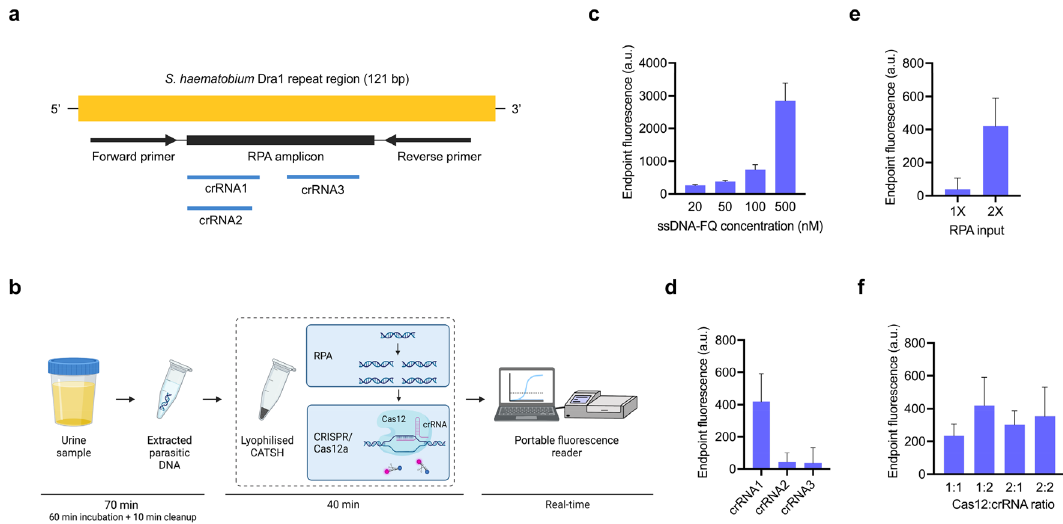
Figure 1. CATSH design and optimisation. ( a ) Visualisation of the targeted S. haematobium Dra1 repeat region with RPA primers, amplicon and crRNAs. ( b ) Schematic of the proposed CATSH workflow. Preparation of urine samples with in-house CATSH-compatible protocol, followed by CATSH testing. Real-time fluorescence is recorded on a portable reader. ( c ) Optimisation of ssDNA-FQ concentration. ( d ) Comparison of three crRNAs. ( e ) Optimisation of RPA input. ( f ) Optimisation of Cas12a to crRNA ratio. All reactions were run in five repeats. Bars represent the average endpoint fluorescence after background subtraction and error bars represent the standard deviation between